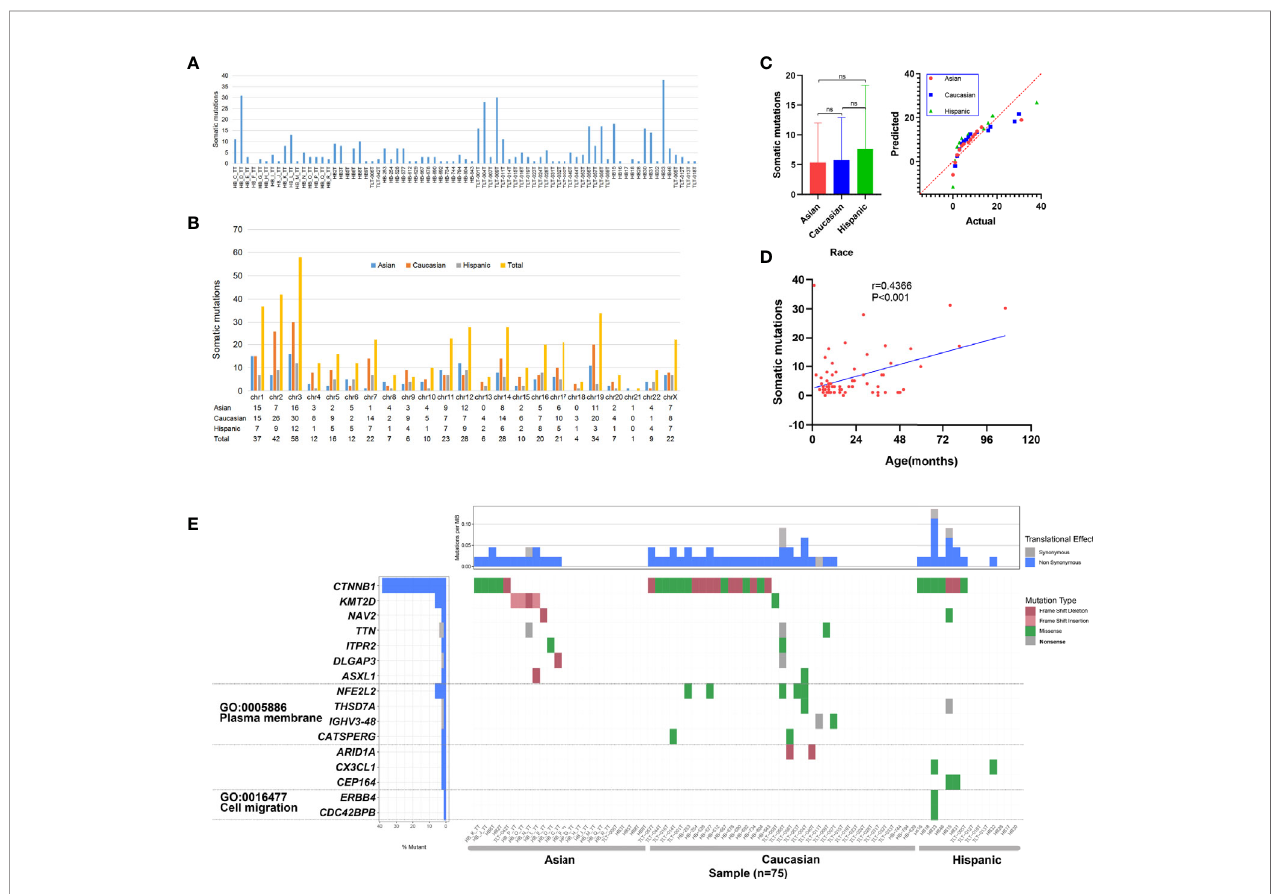
FIGURE 3 | Somatic mutation data of 75 hepatoblastoma (HB) patients. (A) Histogram of somatic mutation data for patient of three different races. (B) Histogram comparison of somatic mutation number data for each chromosome. (C) Statistical analysis of somatic mutation numbers among patients of three races (ns means Asian vs Caucasian: P = 0.841; Asian vs Hispanic: P = 0.387; Caucasian vs Hispanic: P = 0.447; Sidak ’ s multiple comparisons test). (D) The age of disease onset of hepatoblastoma was plotted against the number of somatic mutations, and linear correlation analysis was performed, with the linear regression depicted in blue (r = 0.4366,P < 0.001). (E) Somatic mutations in HB patients of three races. The heatmap displays the landscape of genes with recurrent mutations in HB. The central heatmap shows the mutation status of the genes with recurrent mutations for each tumor. Somatic mutations are colored according to functional class (right). Left, mutation count for each individual